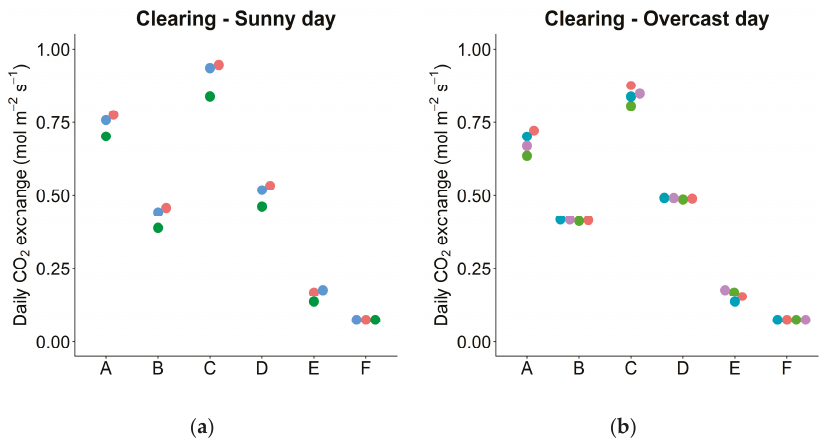
Figure 10. Daily carbon exchange per unit area of leaf in the clearing on ( a ) a sunny day (3 July 2020) and ( b ) an overcast day (24 June 2020). Results of the same leaf simulated in di ff erent scenarios